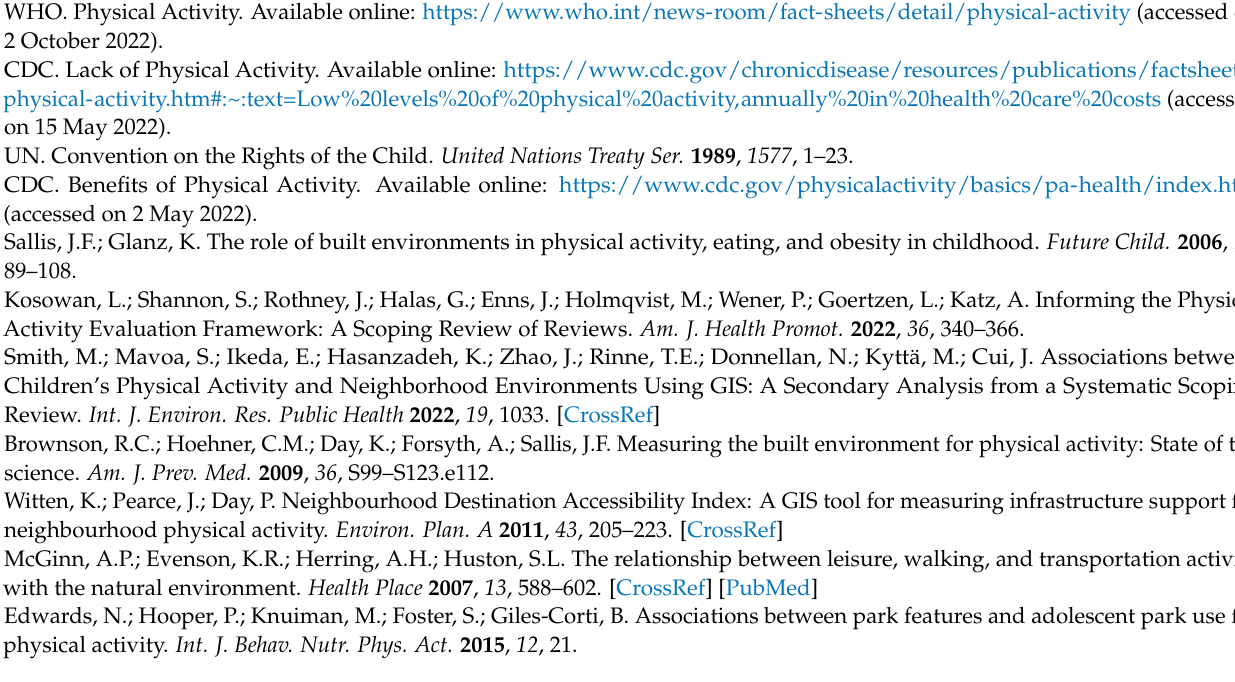
sult; Figure S2: Census Regions and Divisions of the United States (Census, 2021); Table S1: List of